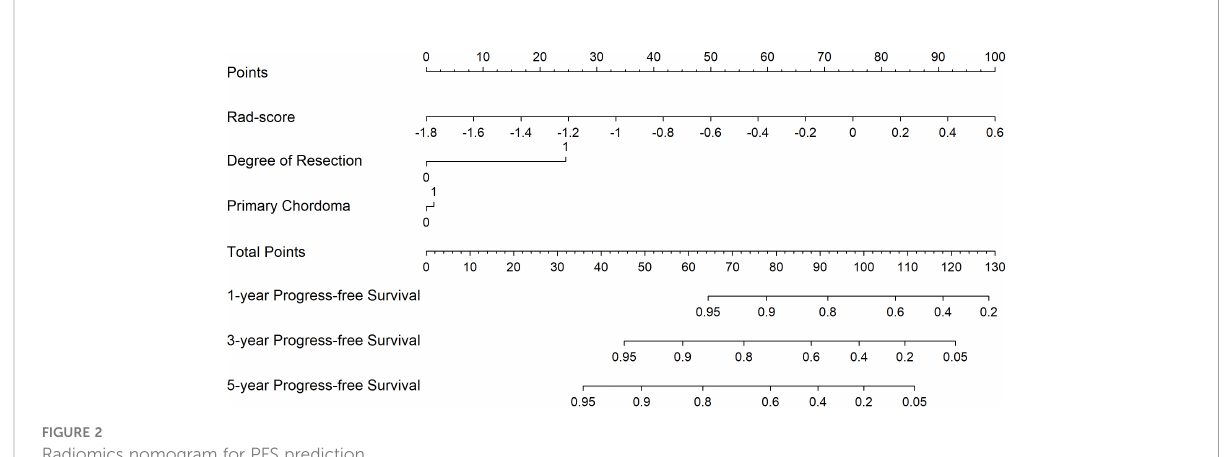
FIGURE 2 Radiomics nomogram for PFS